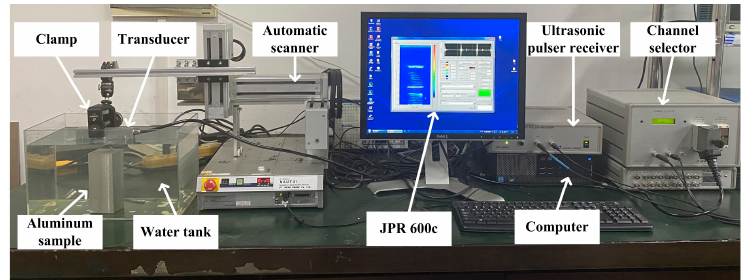
Figure 3. Data acquisition platform. Table 1. Acquisition and processing parameters for the experiment.